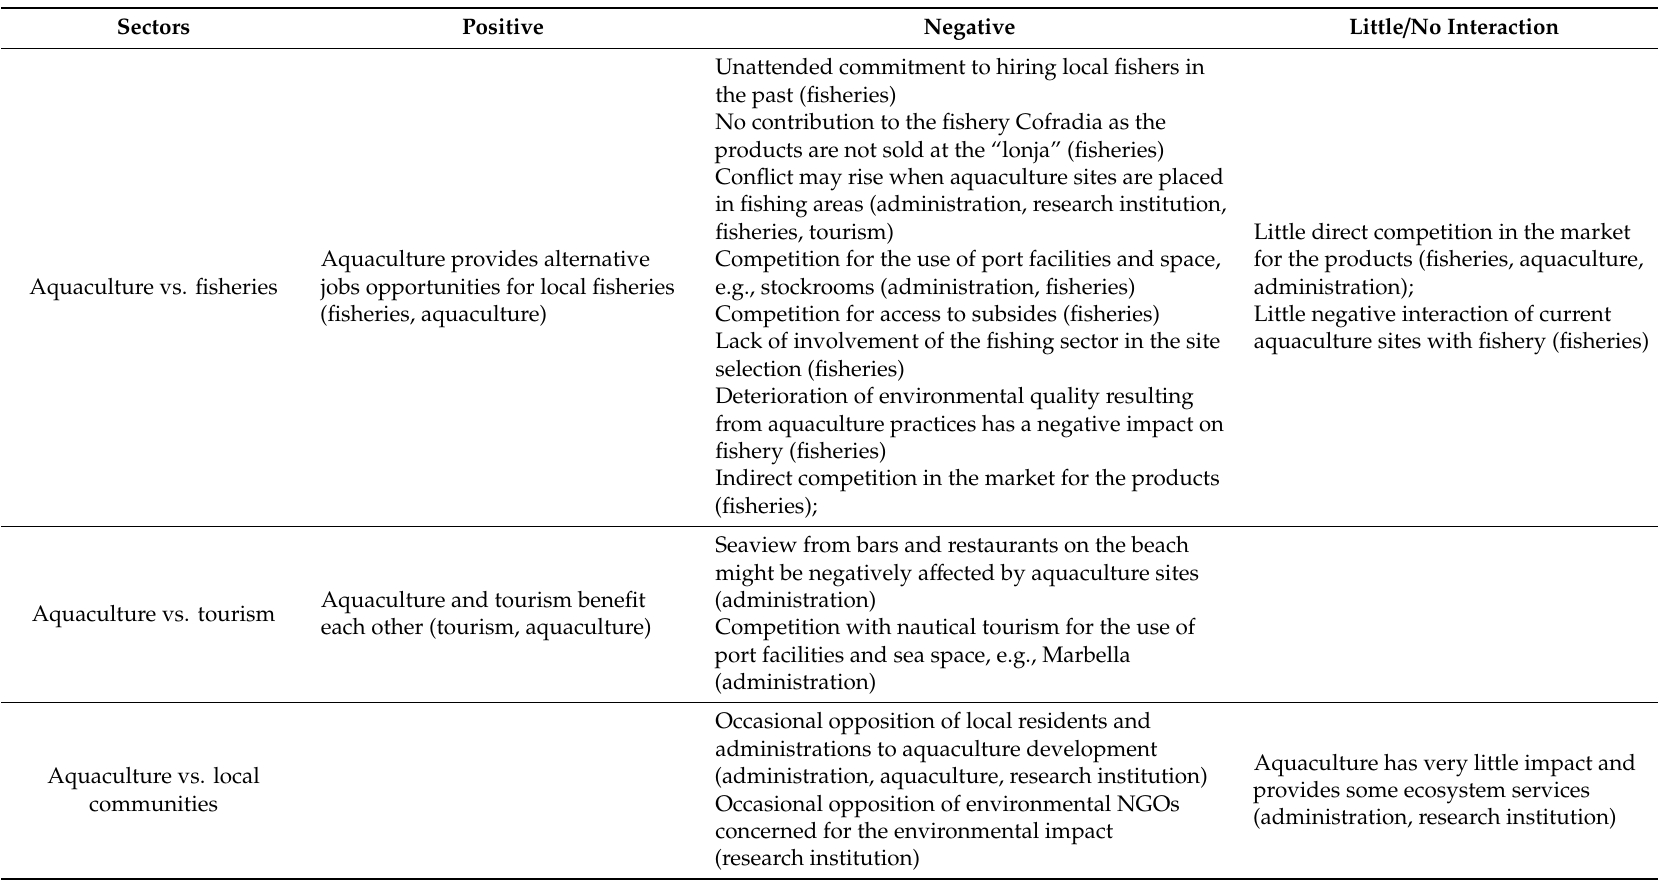
Table 4. Type of interactions among the three maritime sectors and with local community identified by interviewees (in brackets the category of interviewees).